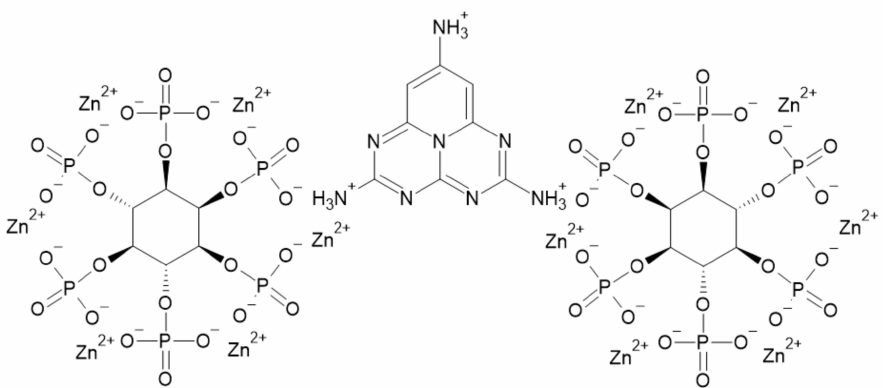
Figure 15. The structure of the (g-C 3 N 4 /PHZn)